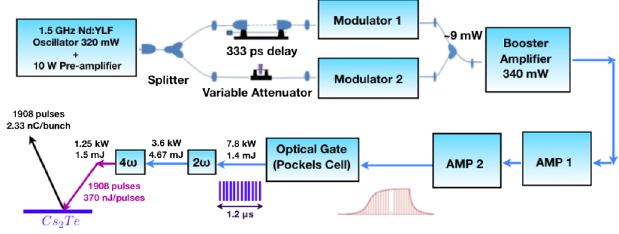
FIG. 1. The layout of the PHIN photoinjector.